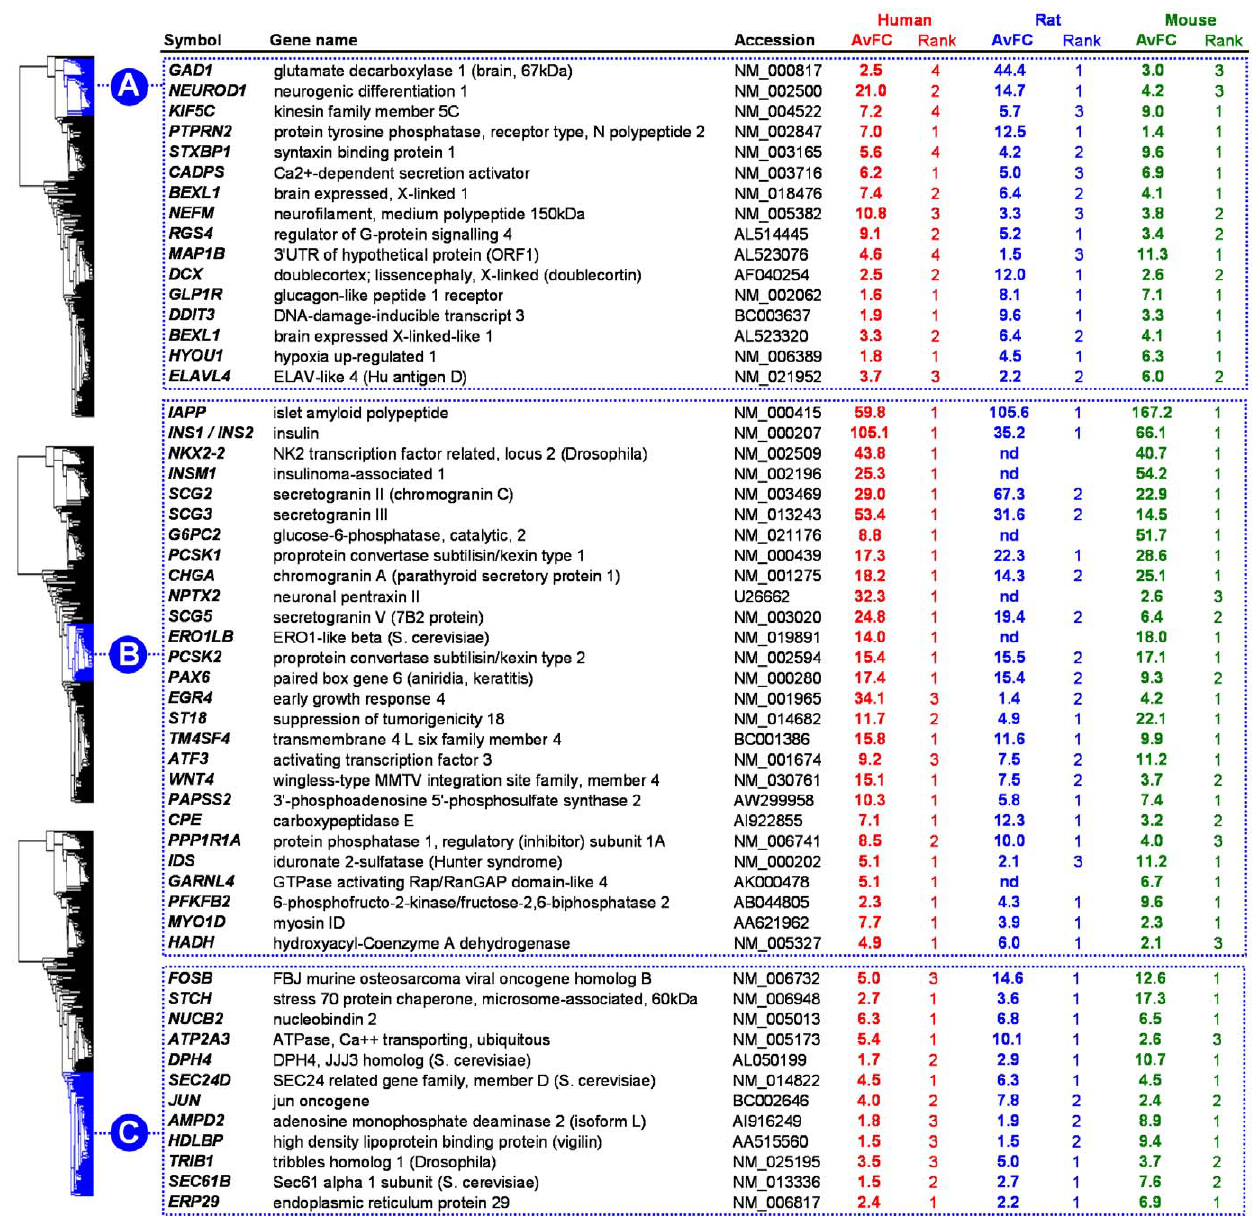
Figure 3. Examples of beta cell marker genes belonging to neuroendocrine cluster A, beta cell selective cluster B and beta-immune cluster C. Average fold change (AvFC) indicates the relative abundance of a given mRNA in the beta cell as compared to the other tested tissues in that species, while lower rank value reflects higher beta cell selectivity (see methods). From each tissue-tropic cluster (A, B, C from Fig. 2), beta cell marker genes with, calculated for the 3 species, an averaged avFC score $ 4, are shown. Relative beta cell abundance (and selectivity) decreases from cluster B over cluster A to cluster C, and consequently this is reflected in number of retained exemplary genes.